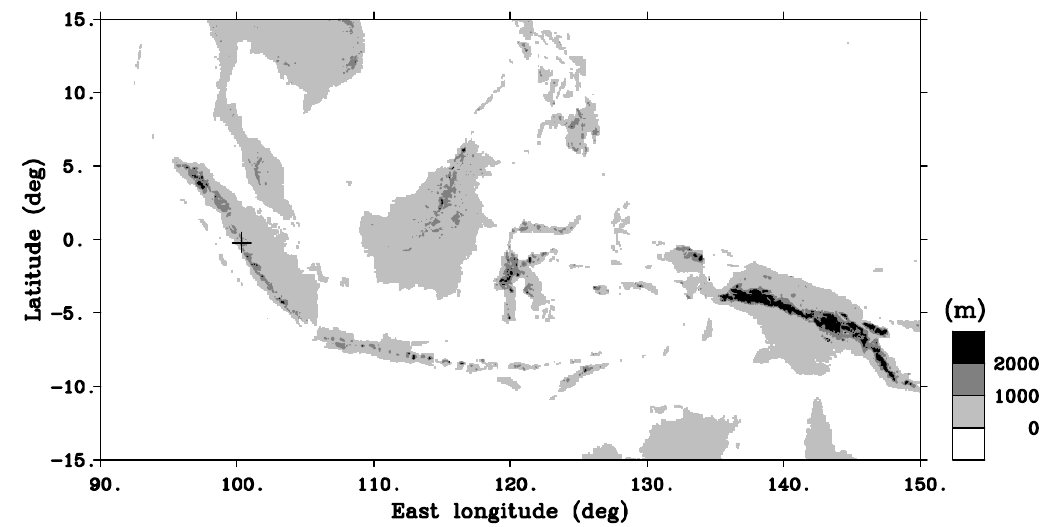
Fig. 1. Geographical map of the Indonesian maritime continent. “+” indicates the location of the observation site (0 . 20 ◦ S, 100 . 32 ◦ E, 865m above sea